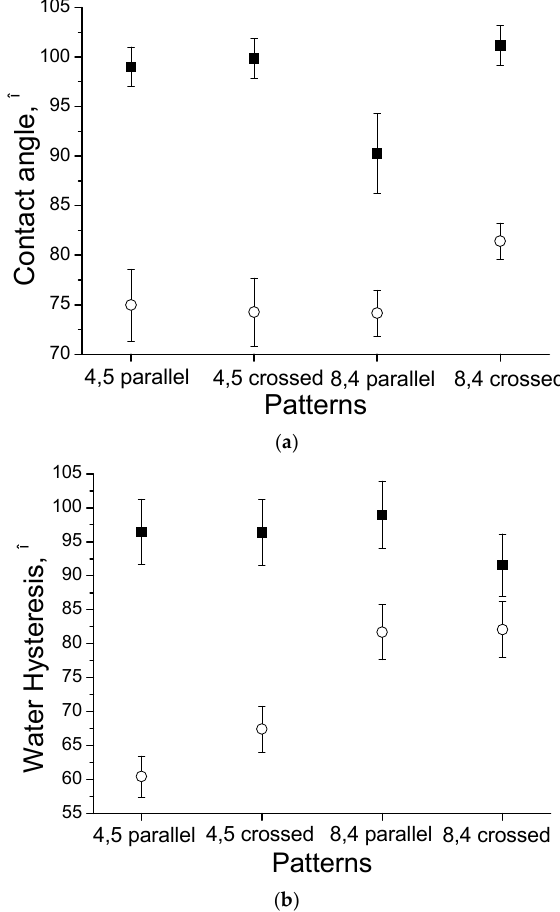
Figure 7. The contact angle ( a ) and water hysteresis; ( b ) measurements for different patterns on the surface of Ti: ■ —without HA film, and ○ —with HA film.